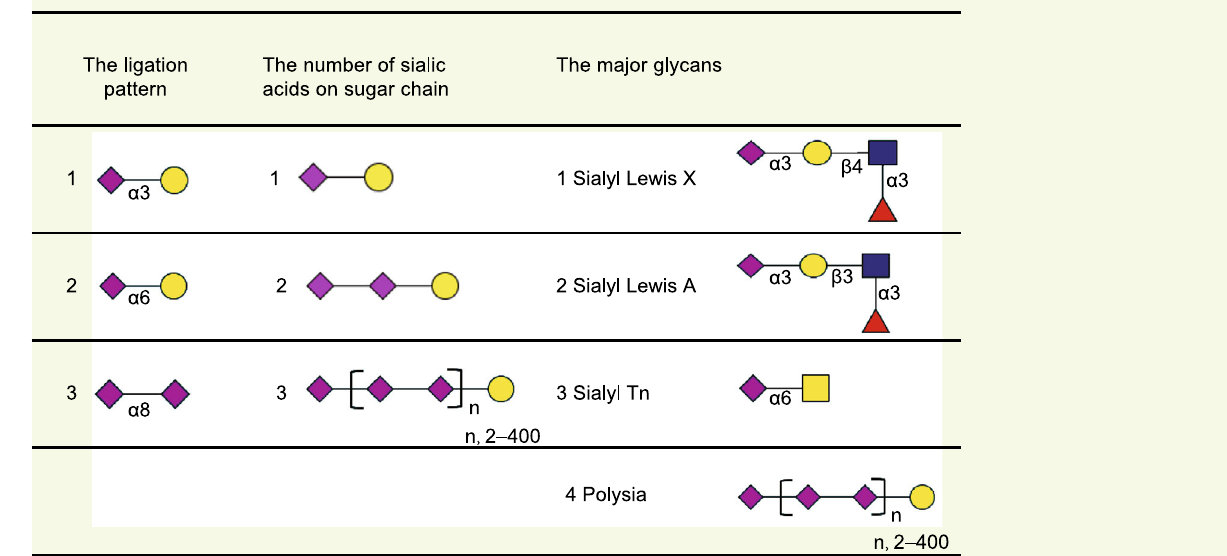
Table 1. The major patterns of sialylated glycoconjugates. GlcNAc, Galactose, Fucose, Sialic